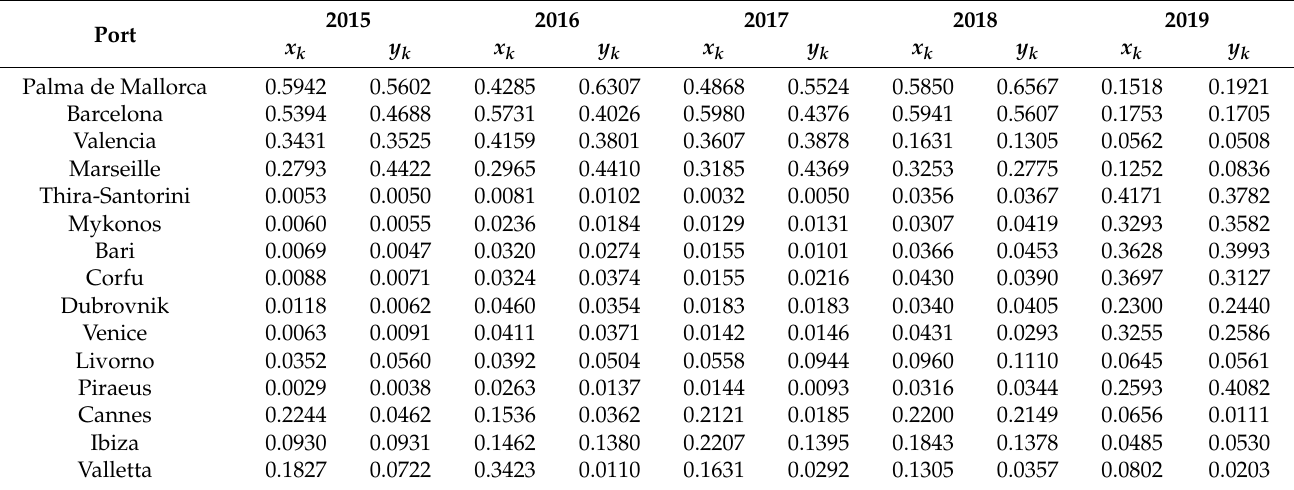
Table 9. Top 15 ports in terms of authority and hub weights and its evolution from 2015 to 2019 in the contemporary cruise network in Southern Europe.